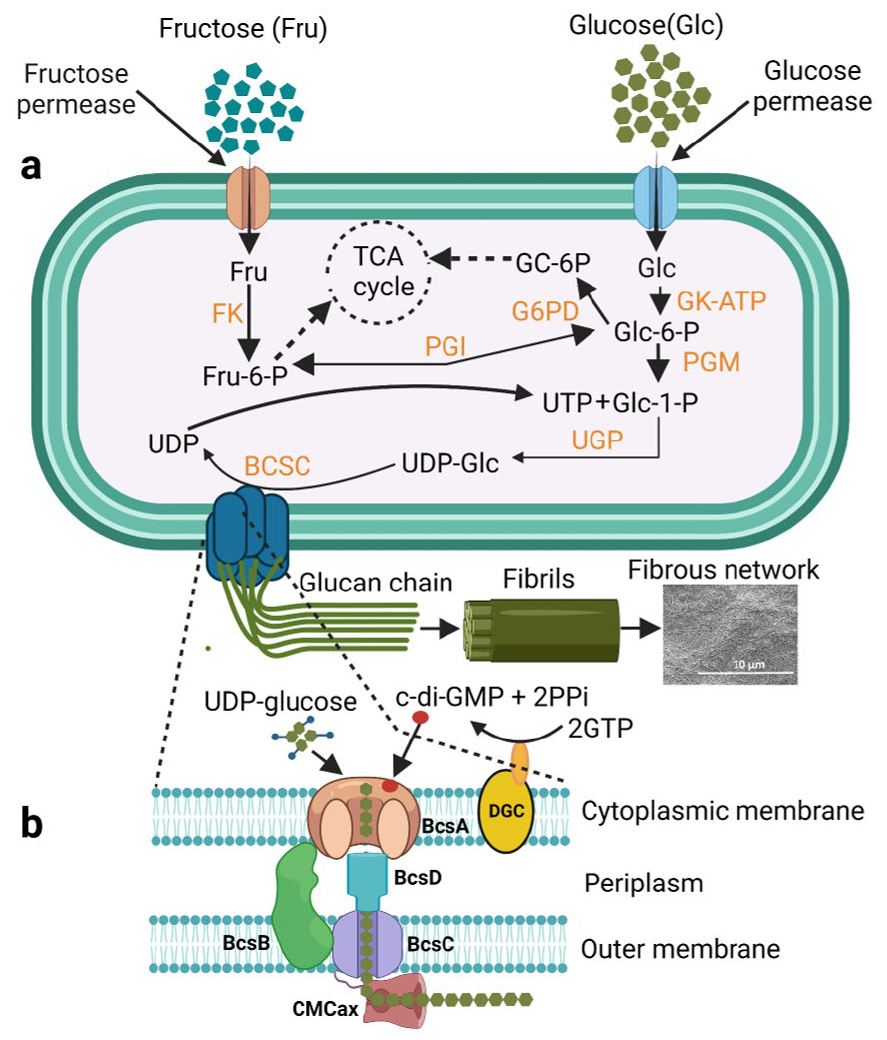
Figure 2. ( a ) The proposed mechanism of BC biosynthesis in K. xylinus using glucose and fructose as carbon sources and assembly of cellulose into nanofibrils. Glc; glucose, Glc-6-P; glucose 6 phosphate, Glc-1-P; glucose 1 phosphate, UDP-Glc; uridine diphosphoglucose (UDP-Glc), GC-6-P; gluconate 6 phosphate, Fru-6-P; fructose 6 phosphate, Fru; fructose, GK-ATP; ATP dependant glucokinase, PGM; Phosphoglucomutase, UGP; UDP–glucose pyrophosphorylase, G6PD; Glucose-6-phosphate dehy- drogenase, PGI; phosphoglucoisomerase, FK; fructokinase and BCSC; bacterial cellulose synthase complex and ( b ) membrane-based cellulose synthase complex (Created with BioRender.com; access date 4 November